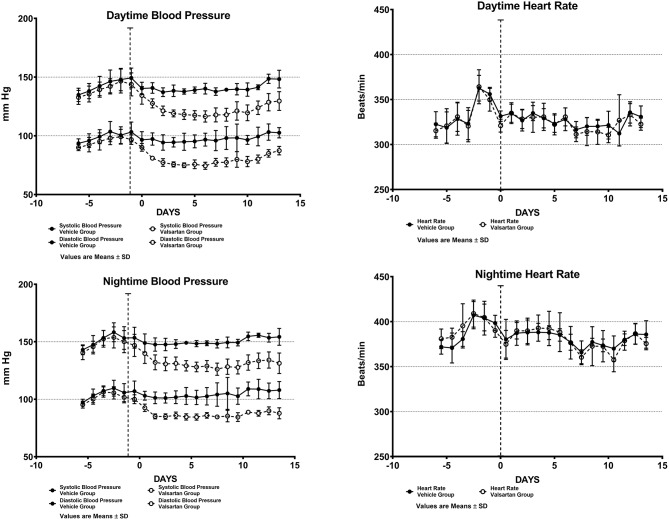
Arterial blood pressure and heart rate measures from chronically implanted radiotelemetry probes in transgenic rats expressing the human sequence of the angiotensinogen gene before and throughout a fortnight exposure to oral therapy with the AT1-R antagonist valsartan. Values are means ± SD of daytime (upper panels) and nighttime (lower panels) of systolic and diastolic blood pressure daily averages.